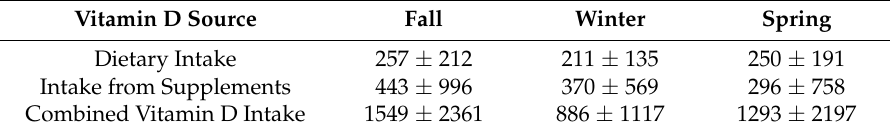
Table 4. Vitamin D intake from food and supplements across the academic year 1 . Vitamin D Source Fall Winter Spring Dietary Intake 257 ± 212